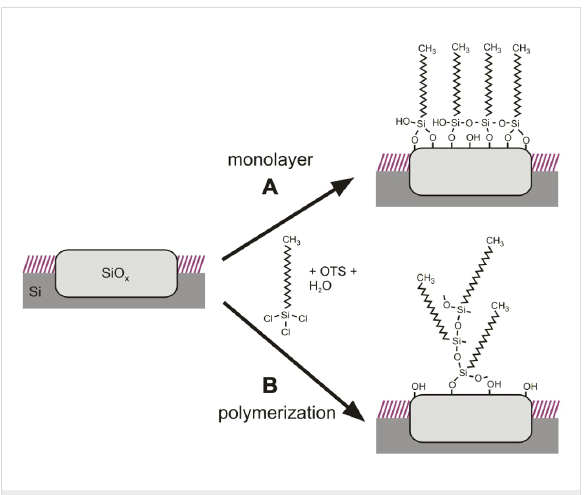
Figure 3: Schematic illustration of the two different possible covalent binding mechanisms of OTS with a silicon oxide surface. (A) formation of a smooth OTS monolayer, (B) vertical